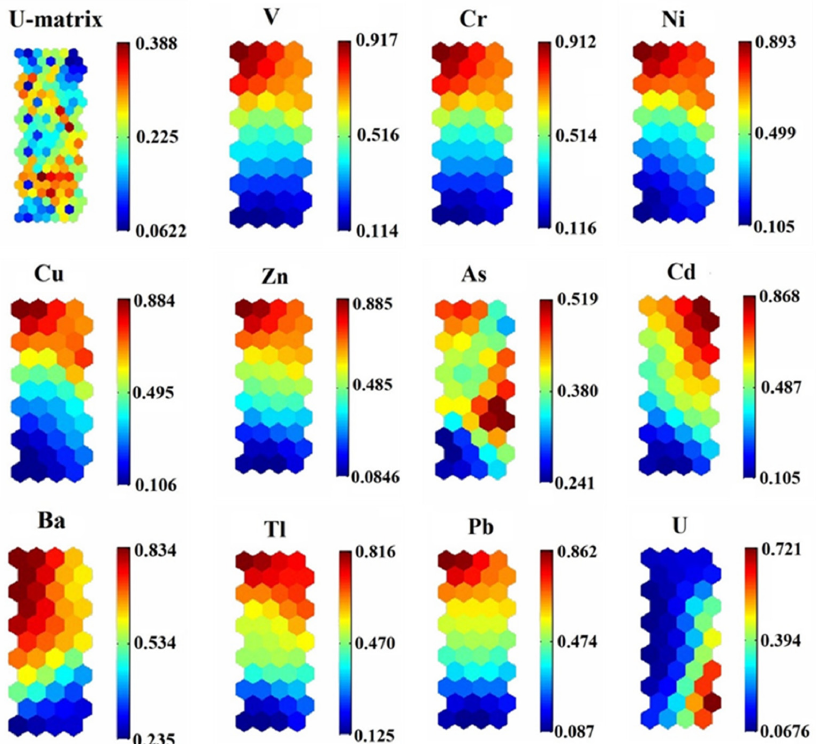
Figure 4. Self-organizing mapping of trace elements. Note: Column labels represent the normalized concentration index. Similar samples are mapped close to each other while different samples are separated. These are represented by different colors. This mapping is based on Euclidean distance.